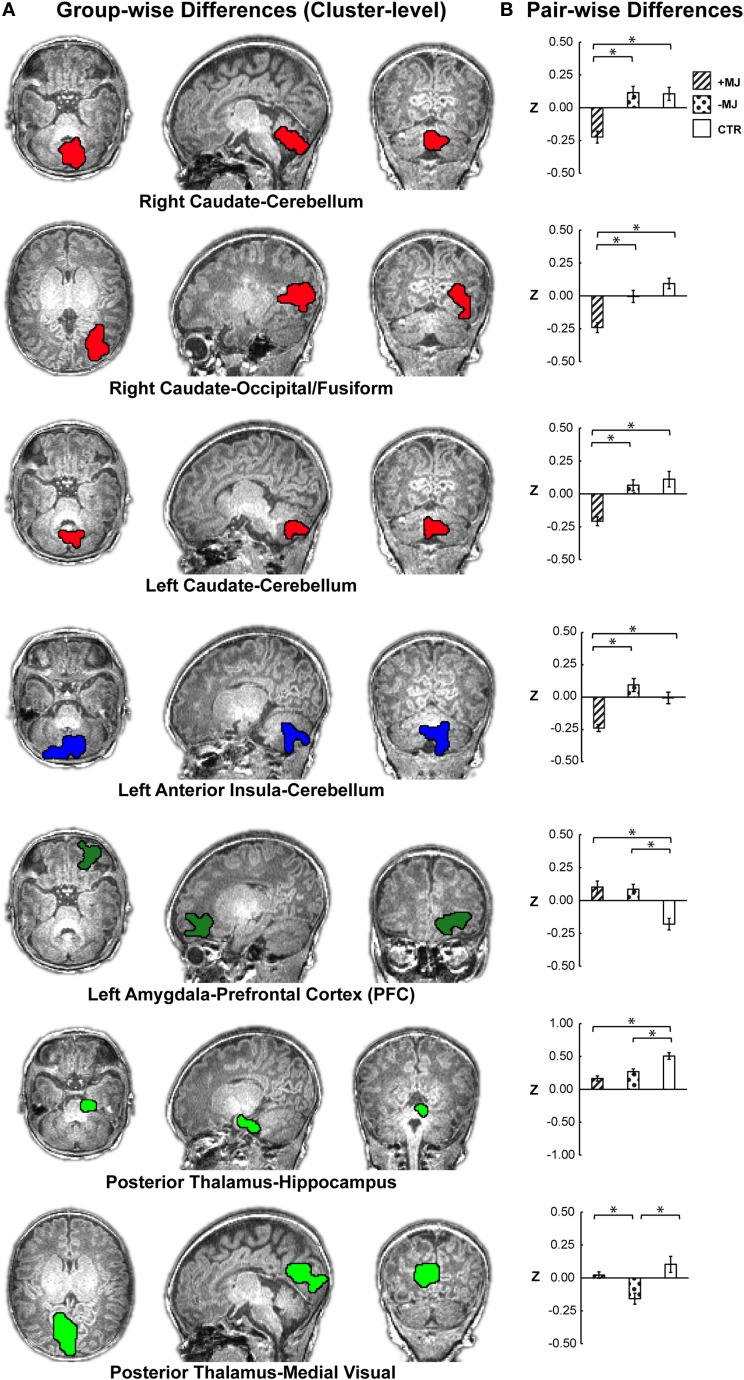
Localization of group-level (+MJ, −MJ, CTR) functional connectivity differences at the cluster level and comparisons by group. (A) Clusters depicted on the high-resolution anatomical reference images. Clusters were detected using the combined threshold approach controlling for gestational age, birth weight, scan age, gender, and scanner (α < 0.05): multivariate group-wise difference (+MJ, −MJ, CTR) p ≤ 0.01, minimum number of voxels = 32, nearest neighbor clustering (NN) = 3. (B) Comparisons of functional connectivity within cluster by neonatal group. (*) indicates significant (p ≤ 0.05 Dunn–Sidak corrected) pair-wise differences between groups while accounting for participant characteristics. Data plotted as mean ± SEM.